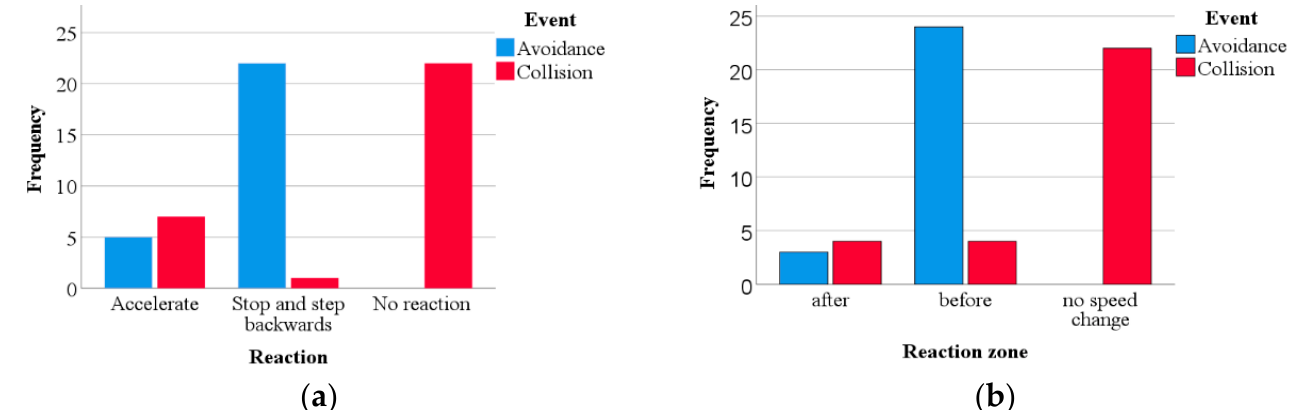
Figure 8. Clustered bar charts of predictors “Reaction” ( a ) and “Reaction zone” ( b ).